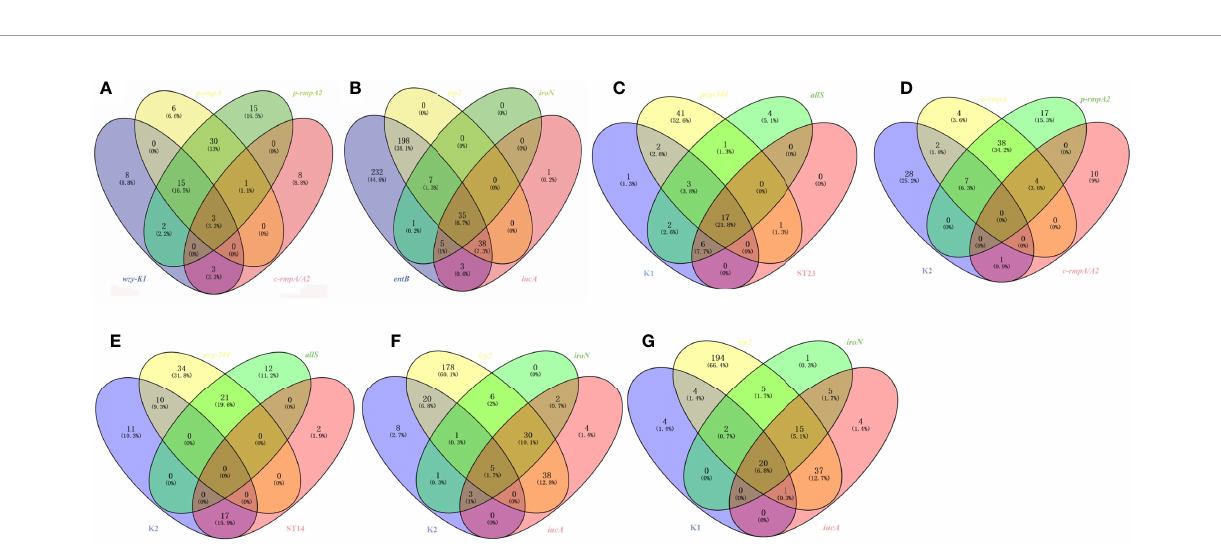
FIGURE 3 | Venn diagrams of various relationships among virulence genes, serotypes and ST types. (A) Venn diagram of wzy-K1 , p-rmpA , p-rmpA2 and c-rmpA/ A2 . (B) Venn diagram of entB , irp2 , iroN and icuA. (C) Venn diagram of K1, peg-344 , allS and ST23. (D) Venn diagram of K2, p-rmpA , p-rmpA2 and c-rmpA/A2. (E) Venn diagram of K2, peg-344 , allS and ST14. (F) Venn diagram of K2, irp2 , iroN and iucA . (G) Venn diagram of K1, irp2 , iroN and iucA. Such relationships were shown in 521 K. pneumoniae